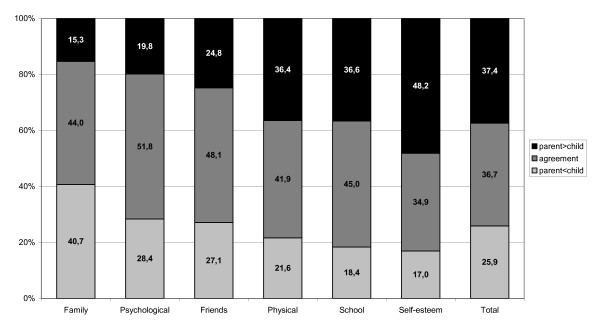
Distribution of agreement/over- or under-estimation between child and parental reports in the dimensions of HRQoL.